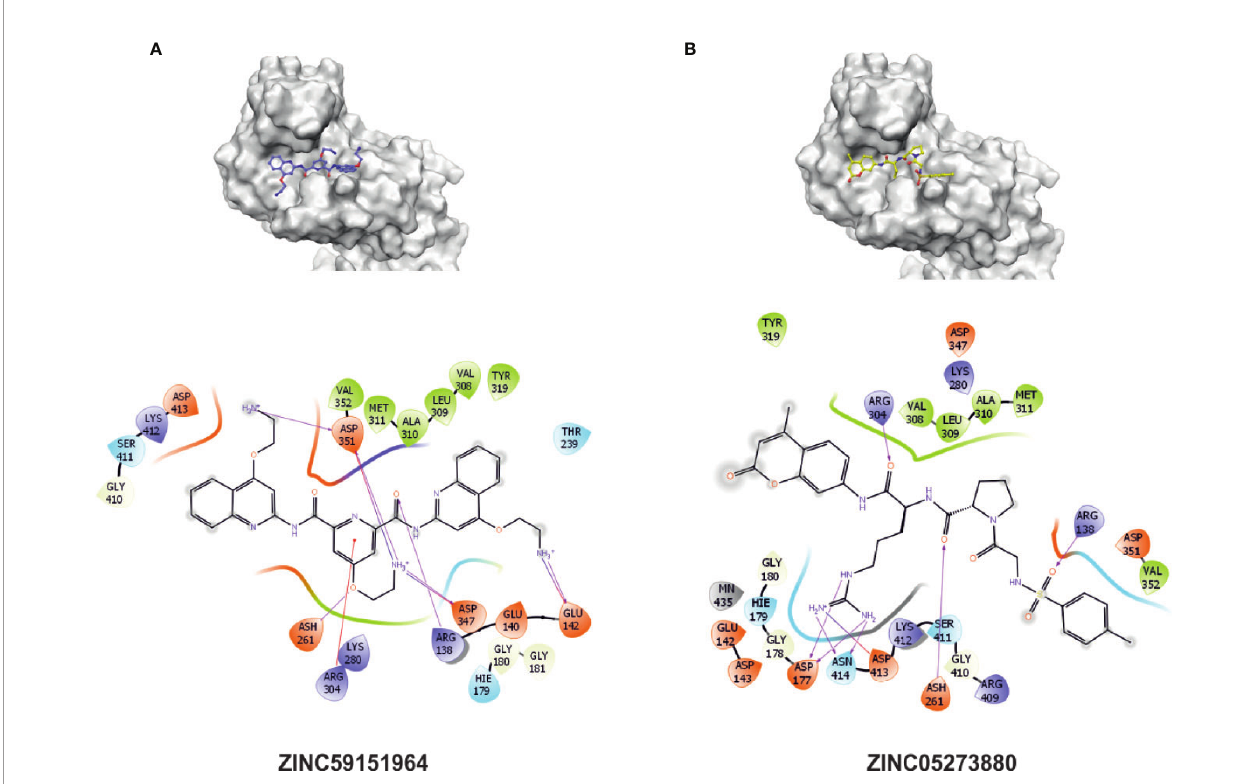
FIGURE 6 | Interaction sites of best experimentally validated compounds. (A) ZINC05273880 interaction diagram and proposed binding pose with the crucial interactions between amino acid residues and the docked molecule highlighted; (B) ZINC59151964 interaction diagram and proposed binding pose with the crucial interactions between amino acid residues and the docked molecule highlighted. Amino acids within a 5 Å radius of the docking pose of the chemical compound are